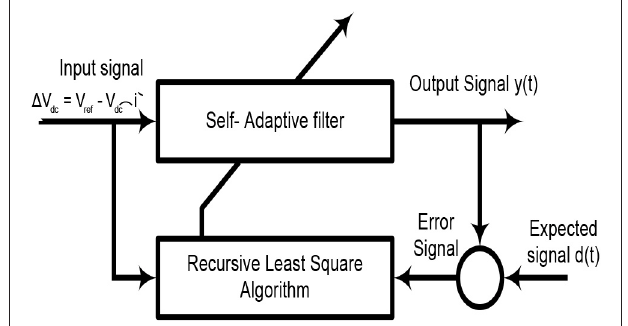
FIGURE 2 | Flow chart of RLS